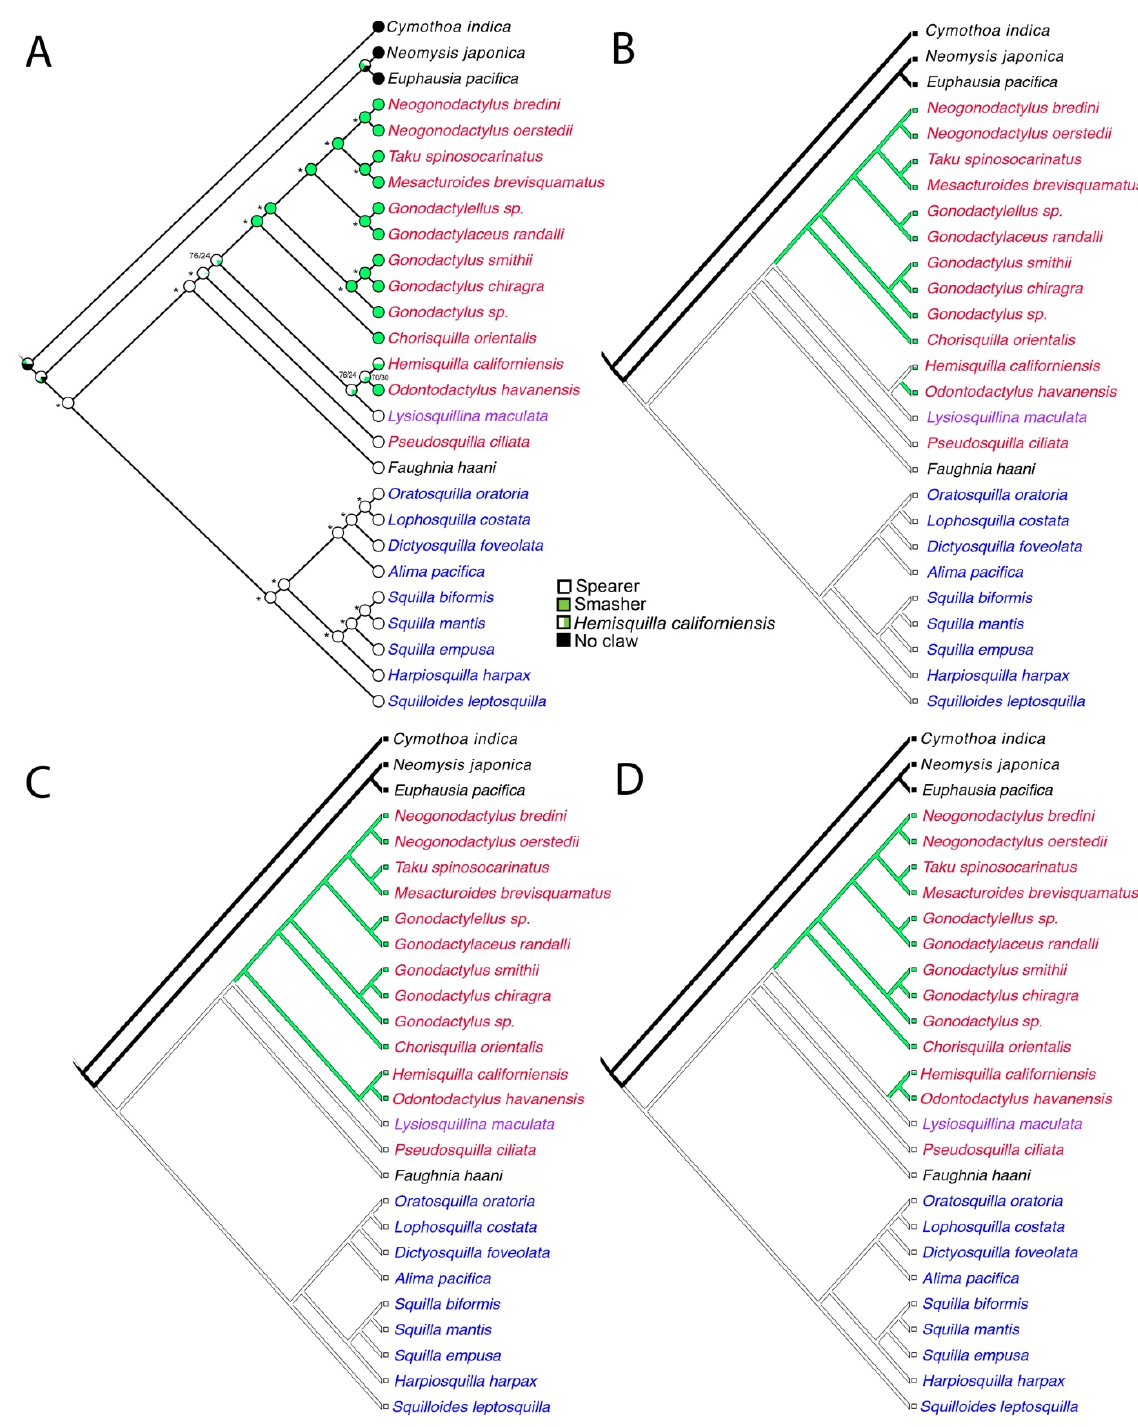
Figure 5 . Ancestral state reconstruction, using Mesquite, of the raptorial claws mapped onto the Eumalocostraca outgroup maximum likelihood tree for the EumalNuc dataset. ( A ) Maximum likelihood reconstruction. Asterisks represent nodes with proportional likelihood estimations of >95%. Other scores for the ingroup are provided in order of most likely states and separated with a forward slash. ( B – D ) The three most parsimonious reconstructions. Coloring of terminal names as in Figures 2 and 3. Hemisquilla californiensis was coded as either spearer or smasher.